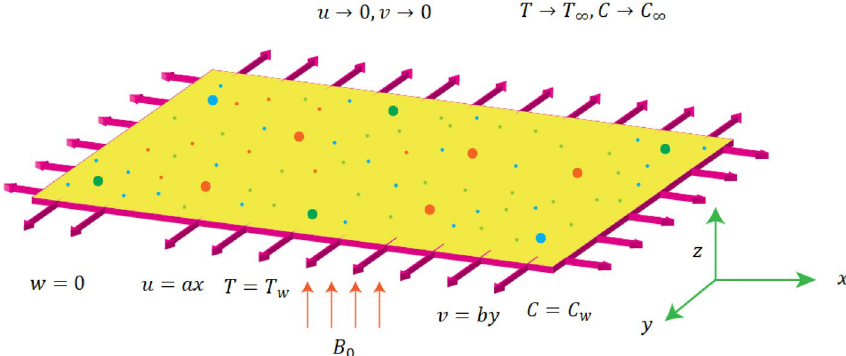
Figure 1. Flow diagram of Prandtl